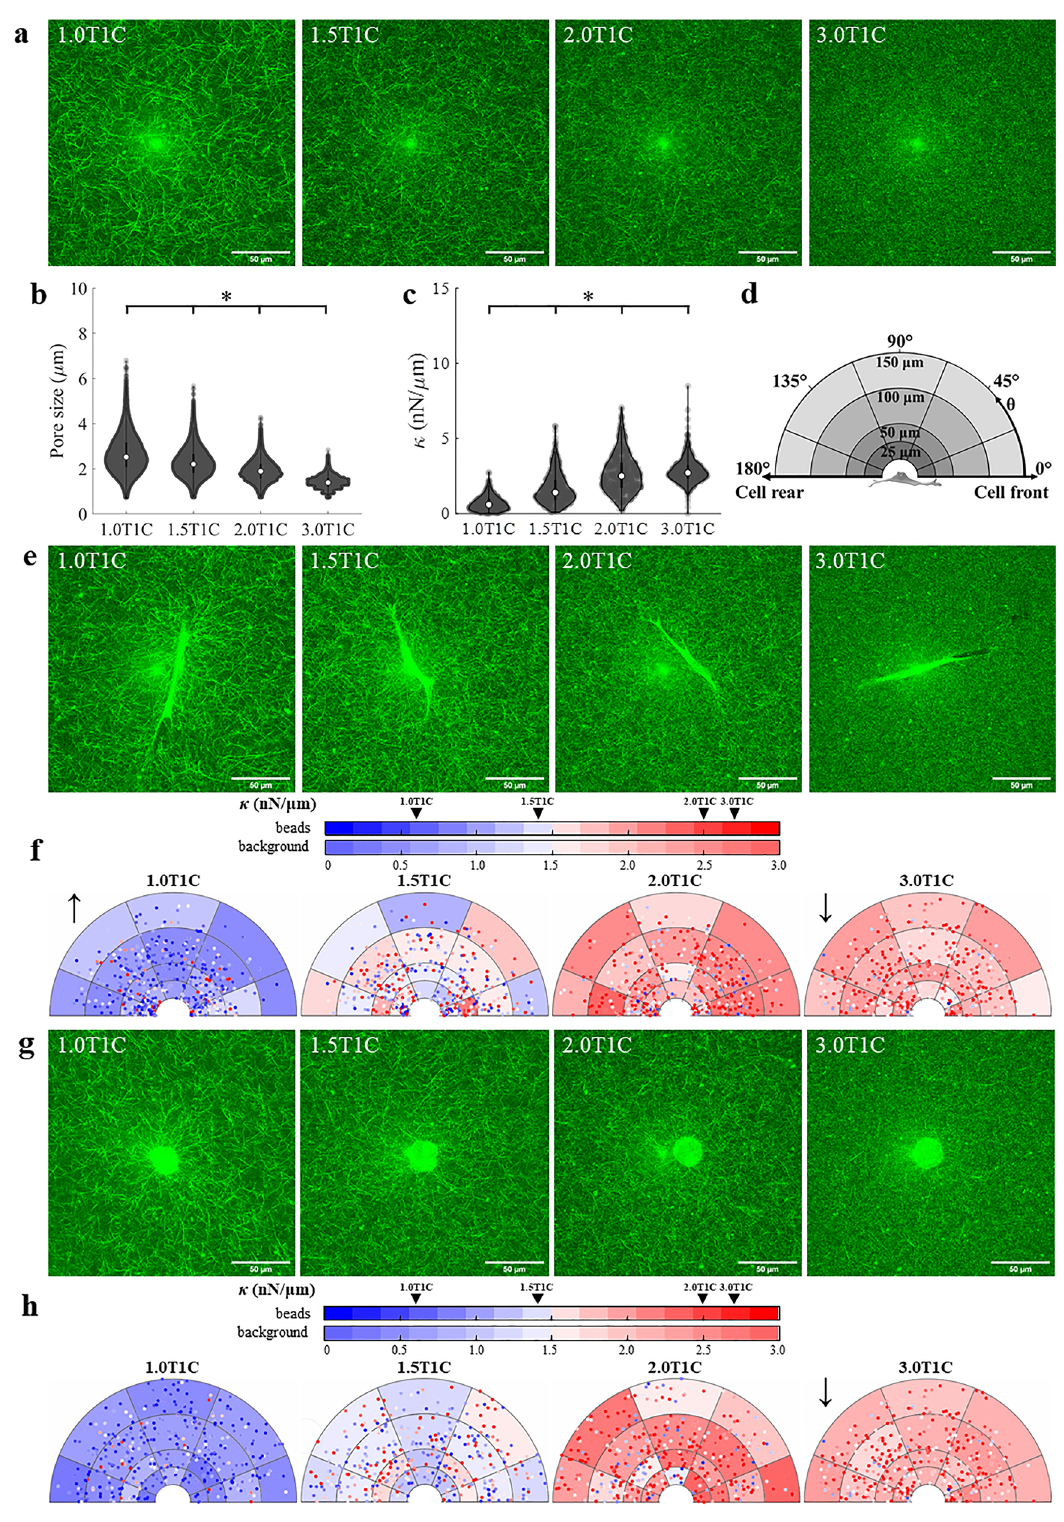
Figure 1. The effect of rat tail T1C concentration on stiffness distribution around DF and HT1080 cells. ( a ) Reflection confocal microscopy (RCM) images of cell-free hydrogels prepared at 4 concentrations (1.0, 1.5, 2.0, 3.0 mg/ml). ( b ) Pore size and ( c ) stiffness ( κ ) distribution of cell-free hydrogels ( n sample = 3 per concentration, n beads > 40 per sample). Median values are denoted by white markers. ( d ) Graphical representation of the coordinate system used to discretize the ECM region around a cell. ( e ) RCM images of DFs. ( f ) Distribution of stiffness around DFs probed along the long axis of the cell ( n sample = 5, n cells = 10 per concentration, n beads > 40 per cell). ( g ) RCM images of HT1080s. ( h ) Distribution of stiffness around HT1080s probed along the horizontal direction of the image ( n sample = 5, n cells = 10 per concentration, n beads > 40 per cell). Background color is shaded according to the median κ value in each bin (background color bar). Each data point is a single probed bead, color-coded for κ (beads color bar). Black arrows indicate a significant difference in κ ( p < 0.05) as compared to cell-free hydrogels of matched concentration. Arrow direction indicates increased or decreased stiffness. * p <